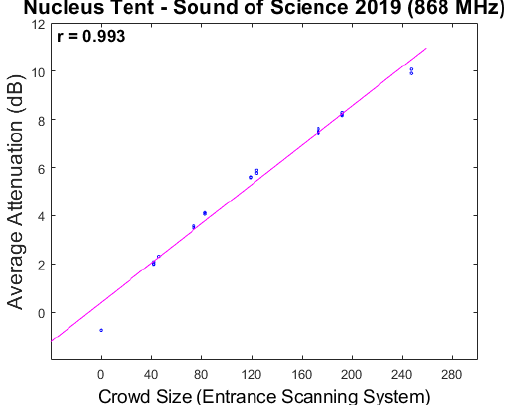
Figure 17. Scatter plots depicting the relationship between the average RSS attenuation and the ground truth in the Nucleus tent